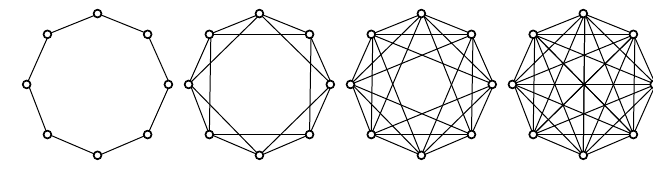
Figure 5: The consecutive circulants C 8 (1) , C 8 (1, 2) , C 8 (1, 2, 3) , and C 8 (1, 2, 3, 4)